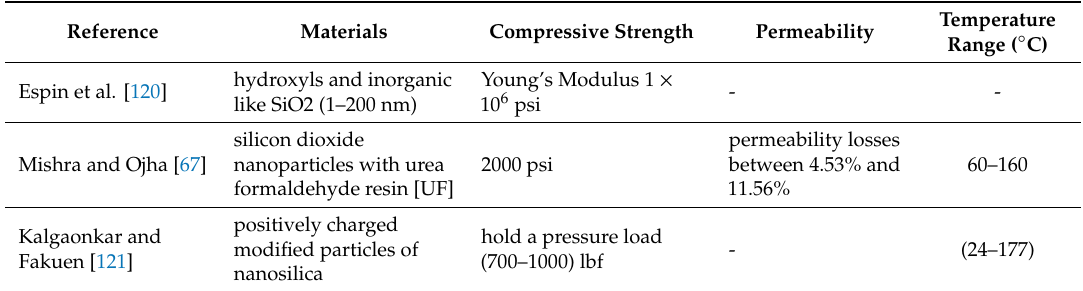
Table 25. Nanoparticles materials methods to consolidate sand formation.